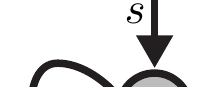
second attractor appears, the system is now bistable. As the stimulus gains more strength, the apex in the nega- tive region also crosses the u -axis (magenta dot), and two zero-crossings disappear, the system is monostable again. ulus parameter are called regimes of the system. The single and one bistable